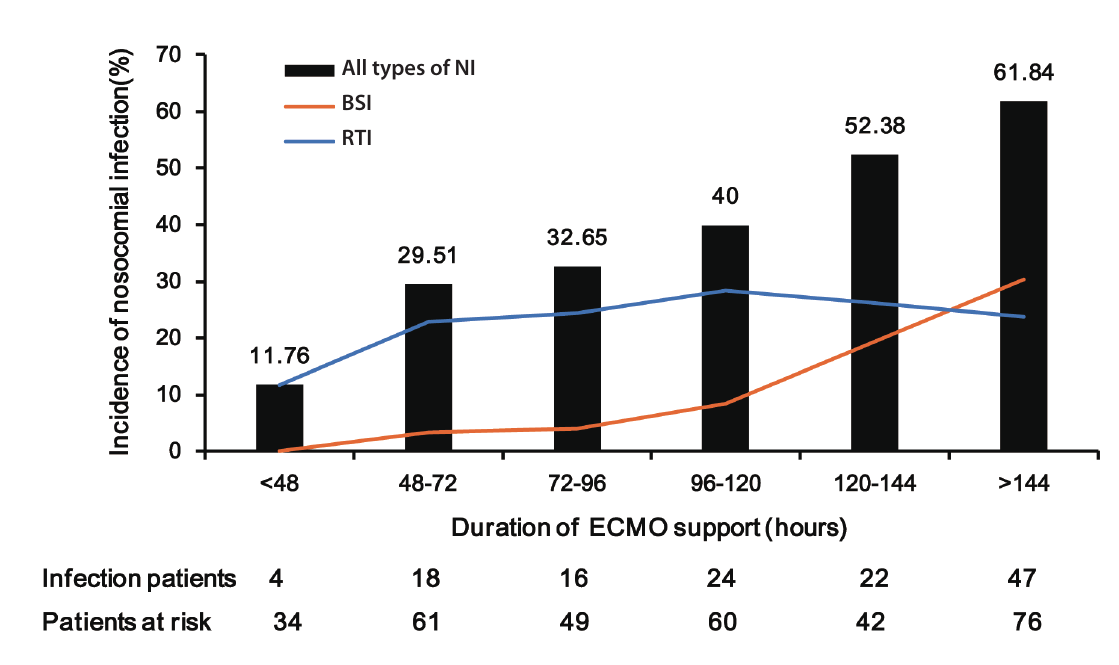
Fig. 1 - Incidence of nosocomial infection (NI) according to the duration of extracorporeal membrane oxygenation (ECMO) support. BSI=blood stream infection; RTI=respiratory tract infection